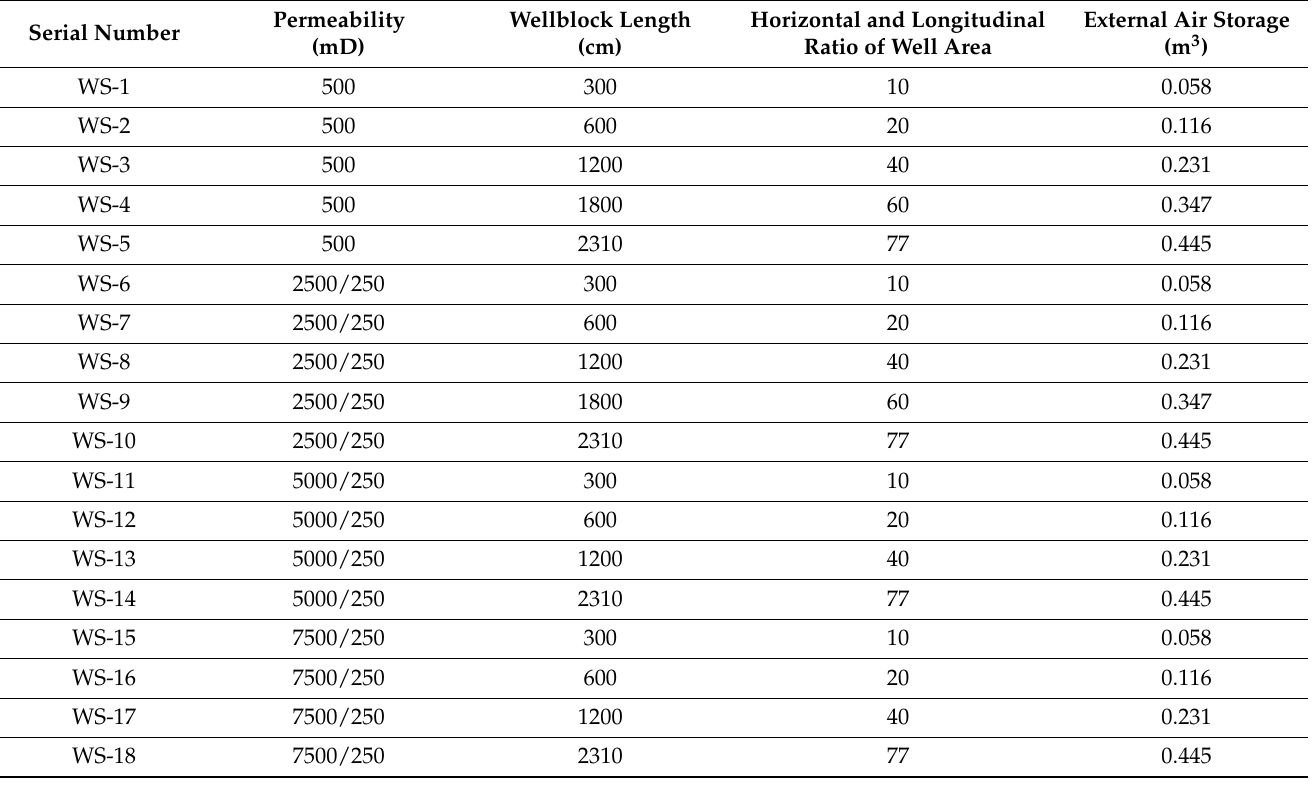
Table 5. The parameters of the physical water invasion simulation experiment